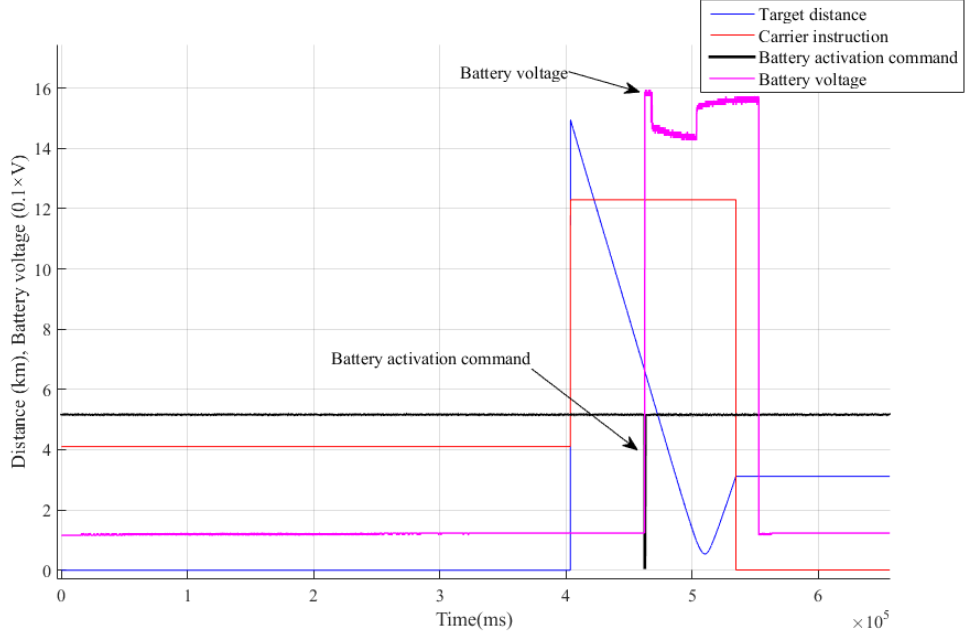
Figure 13. The pod’s power supply voltage.